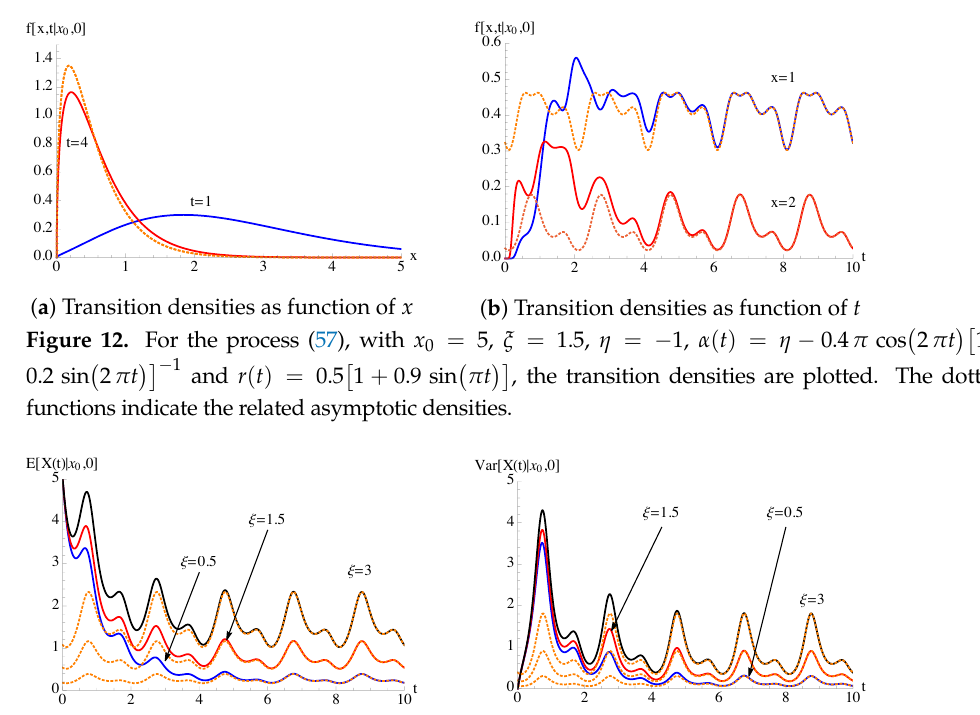
Figure 13. For the process of Figure 12, the conditional means and the conditional variances are plotted as function of t for various choices of ξ . The dotted functions indicate the corresponding asymptotic means and variances.